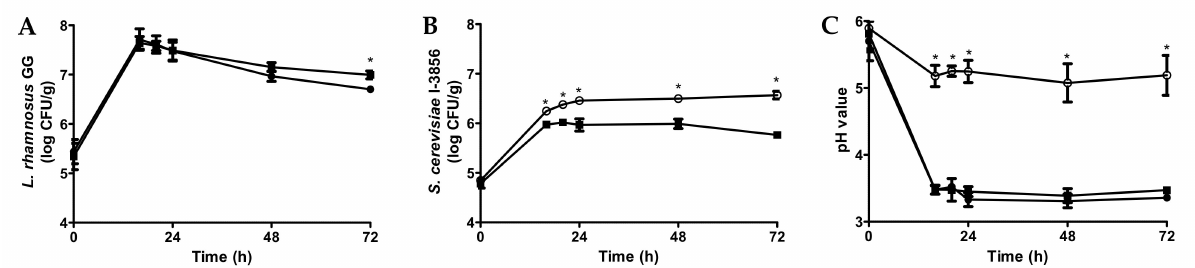
Figure 1. Changes in viable L. rhamnosus GG ( A ) and S. cerevisiae CNCM I-3856 ( B ) cell counts and changes in pH ( C ) during 37 ◦ C incubation in bread slurries (2.5% total solids) inoculated